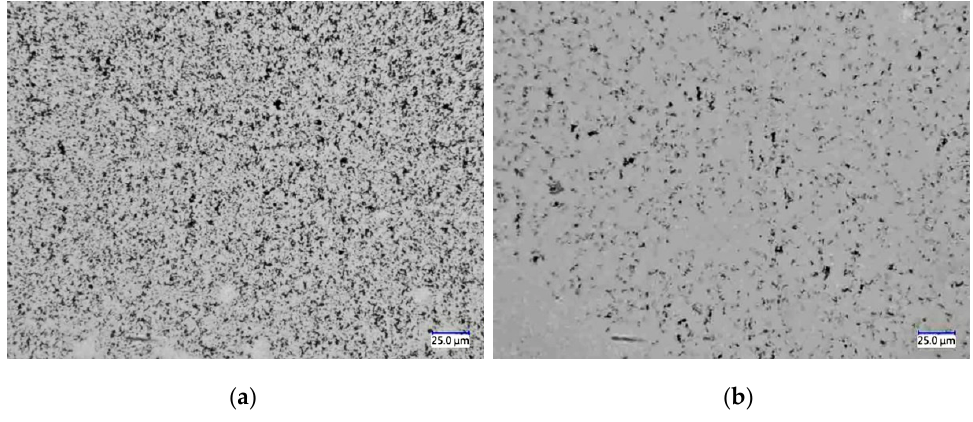
Figure 2. The 1320 °C WC microstructure (OM): ( a ) no Ni added and ( b ) with Ni added. Figure 2. The 1320 ◦ C WC microstructure (OM): ( a ) no Ni added and ( b ) with Ni